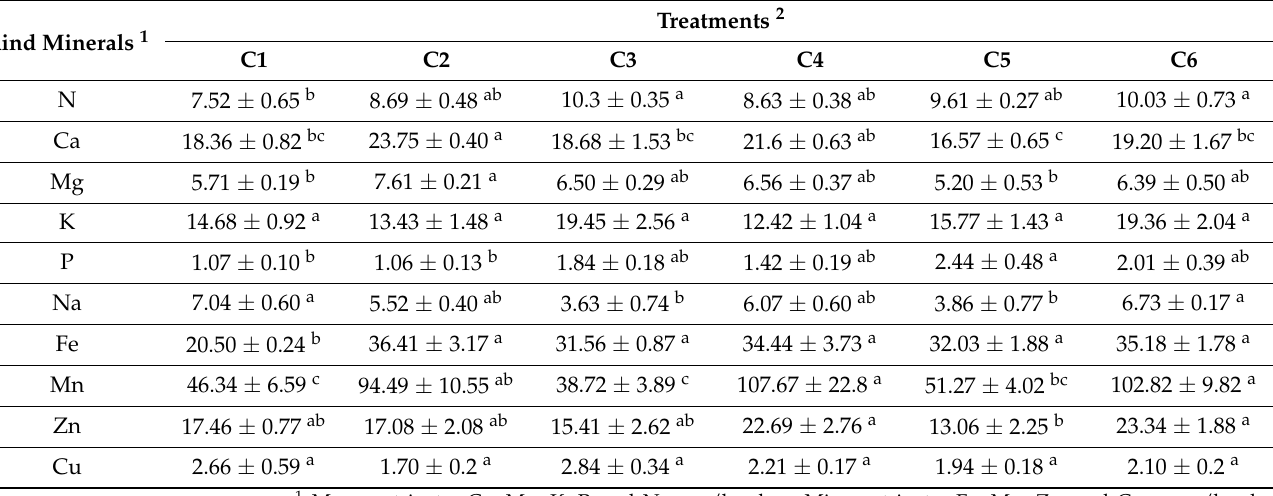
Table 4. The effects of fertilizer and microbial inoculants on mineral composition in the Aloe vera outer green rind of the